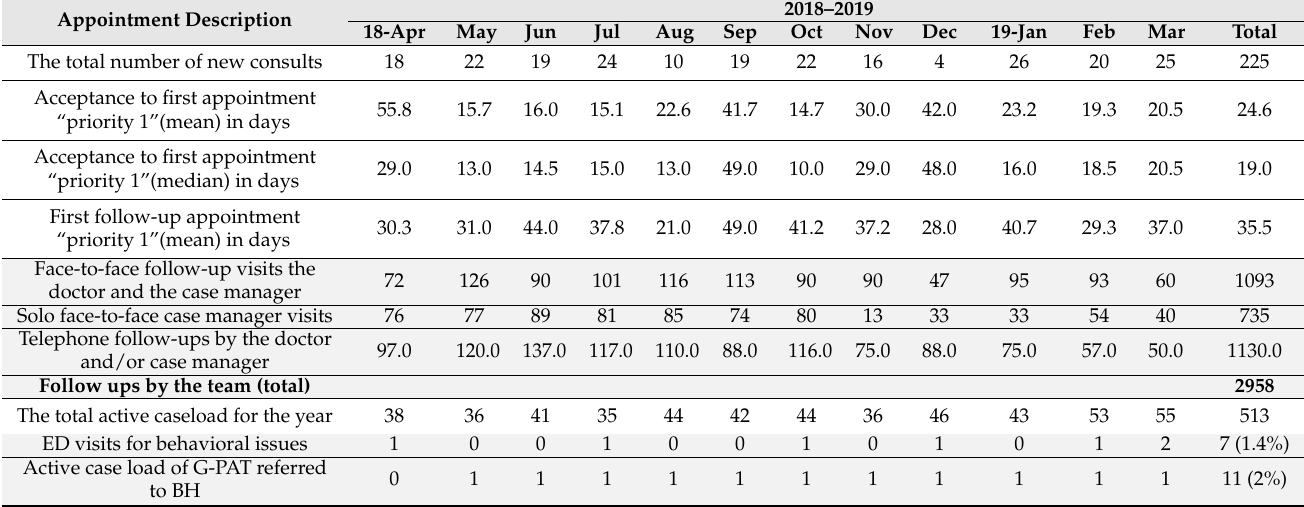
Table 2. The timelines for the initial assessment and first follow-up visits for